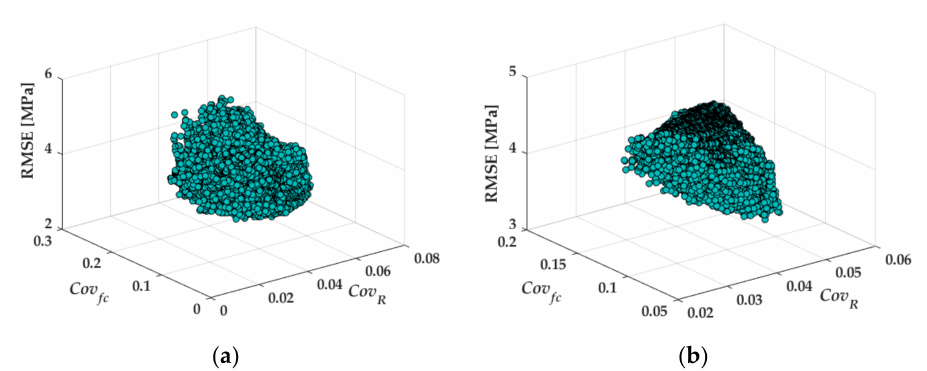
Figure 3. RMSE (Equation (10)) evaluated for the linear conversion models vs. coefficient of variation of the in-situ concrete strength Cov fc and coefficient of variation of the rebound index Cov R : ( a ) m = 11; ( b ) m = 18.